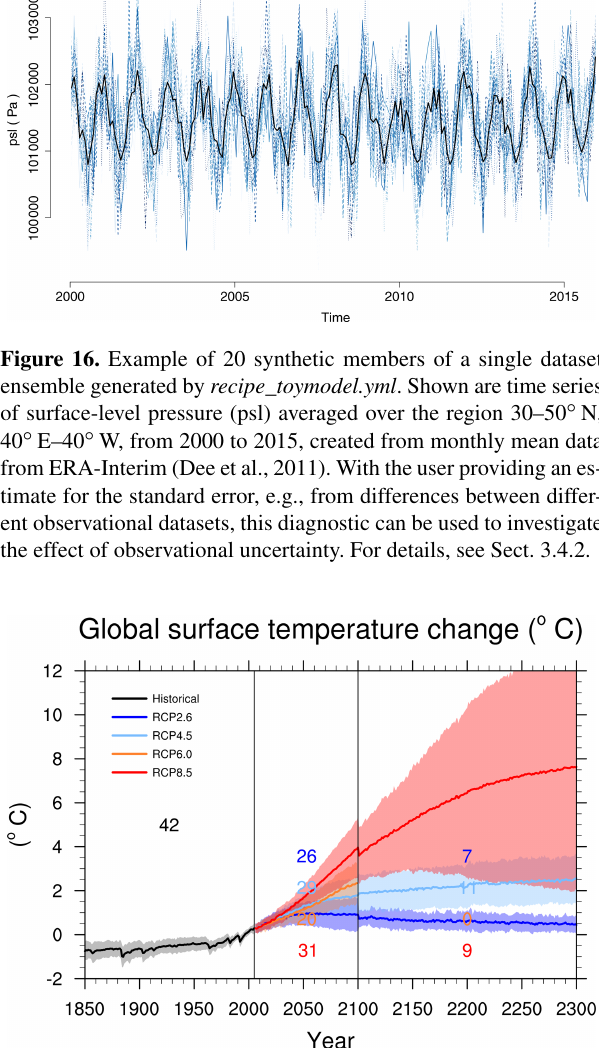
also shows quite large regions where the projections are still uncertain; i.e., the multi-model mean signal is smaller than 1 standard deviation of the natural variability estimated from pre-industrial control simulations